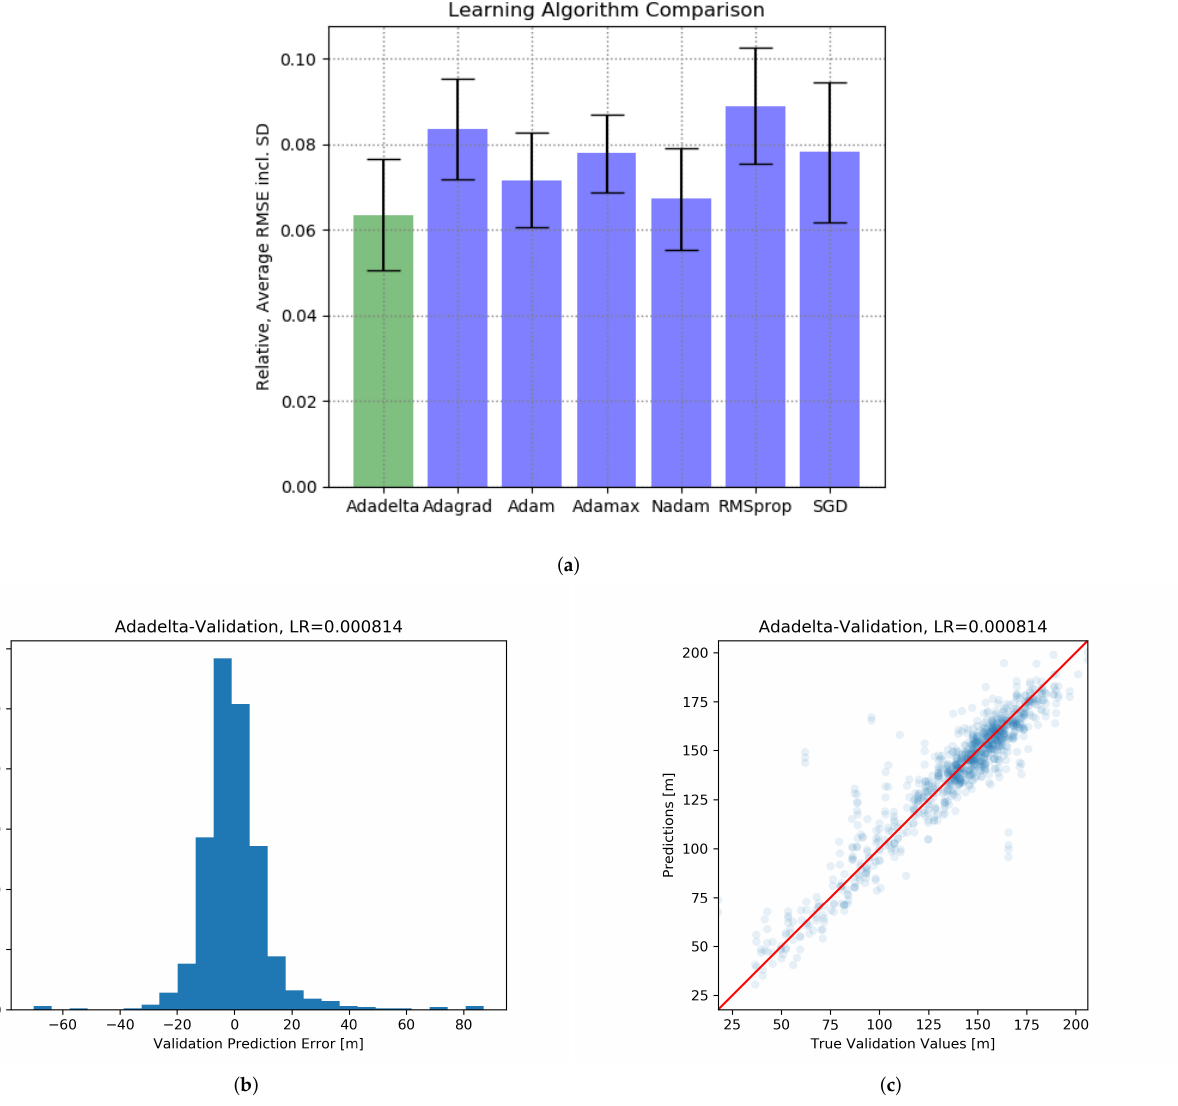
Figure 4. ( a ) Optimization algorithm comparison. MSE arr as prediction quality and its SD for each algorithm; ( b , c ) Prediction distribution; individual results of the best regressor model after completing the FFDB as total error [Abbreviations: SD = Standard Deviation; FFDB = Fractional Factorial Design Benchmark; LR = Learning